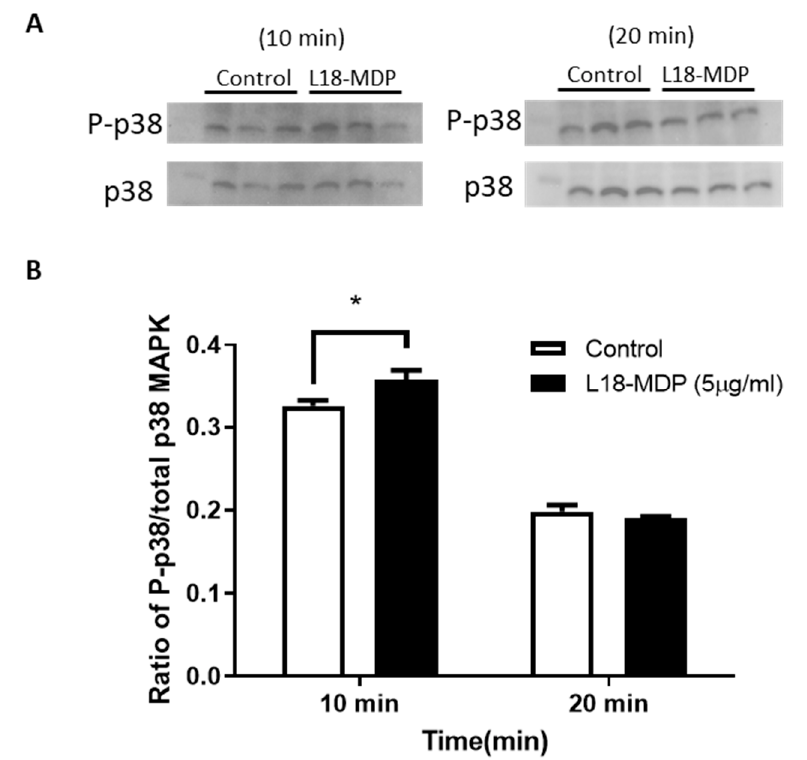
Figure 3. L18-MDP activates the mitogen-activated protein kinase (MAPK) signaling pathway in GLUTag cells after a 10 min exposure to L18-MDP. GLUTag cells were treated with 5 µ g / mL L18-MDP for 10 or 20 min and phospho-p38 and total p38 MAPK were examined by western blot ( A ). Densitometry for P-p38 / p38 was calculated ( B ), n = 3. Results were analyzed by two-way ANOVA and Sidak’s post-hoc test. * p < 0.05. Values shown as mean ± SEM.